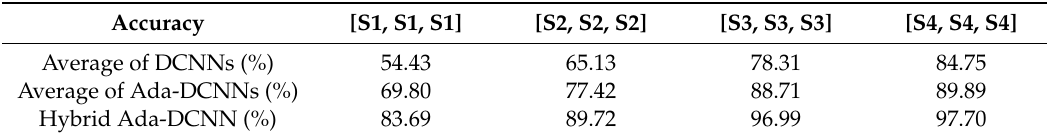
Table 7. The accuracy of the hybrid Ada-DCNN as well as the average accuracy of related Ada-DCNNs and DCNNs for each